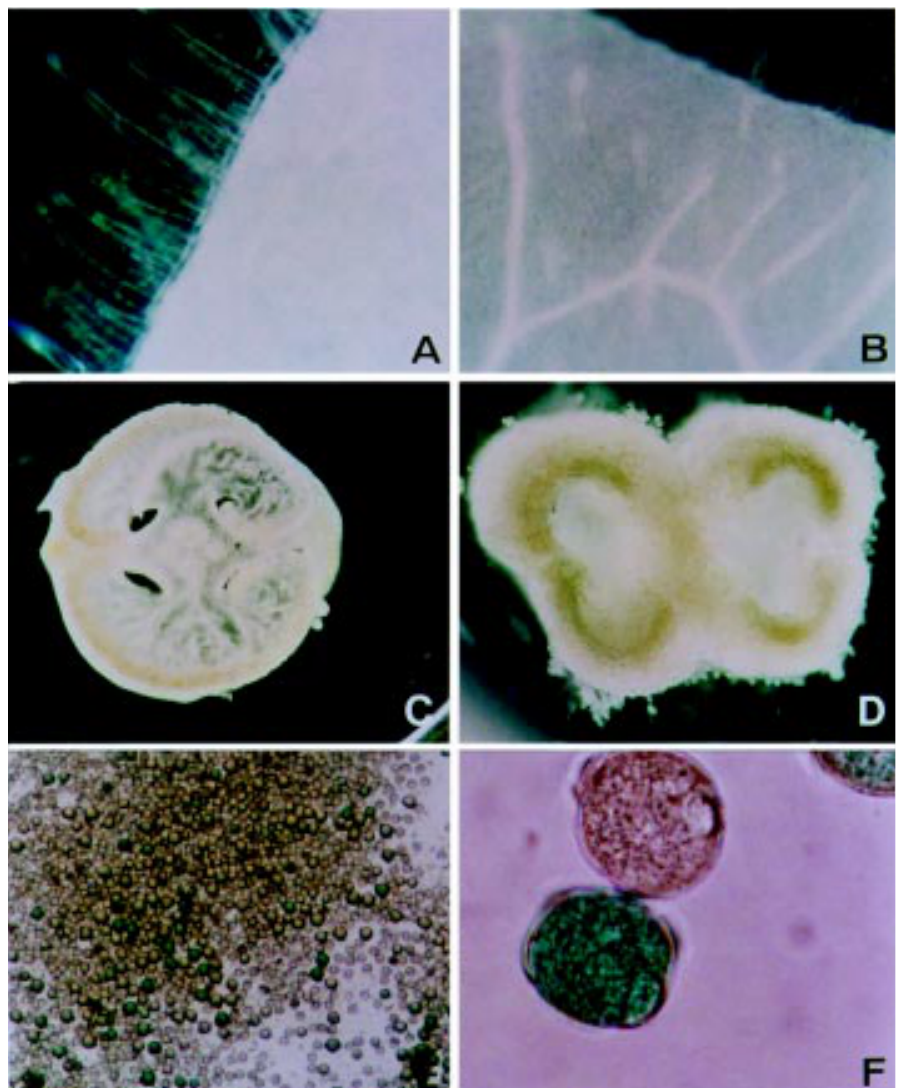
Figure 3 - Histochemical GUS assays of different plant organs in G9- GUS transgenic tobacco at anther stage 10. A , Leaf; B , petal; C , ovary; D , anther with blue-colored microspores; E,F , mature pollen